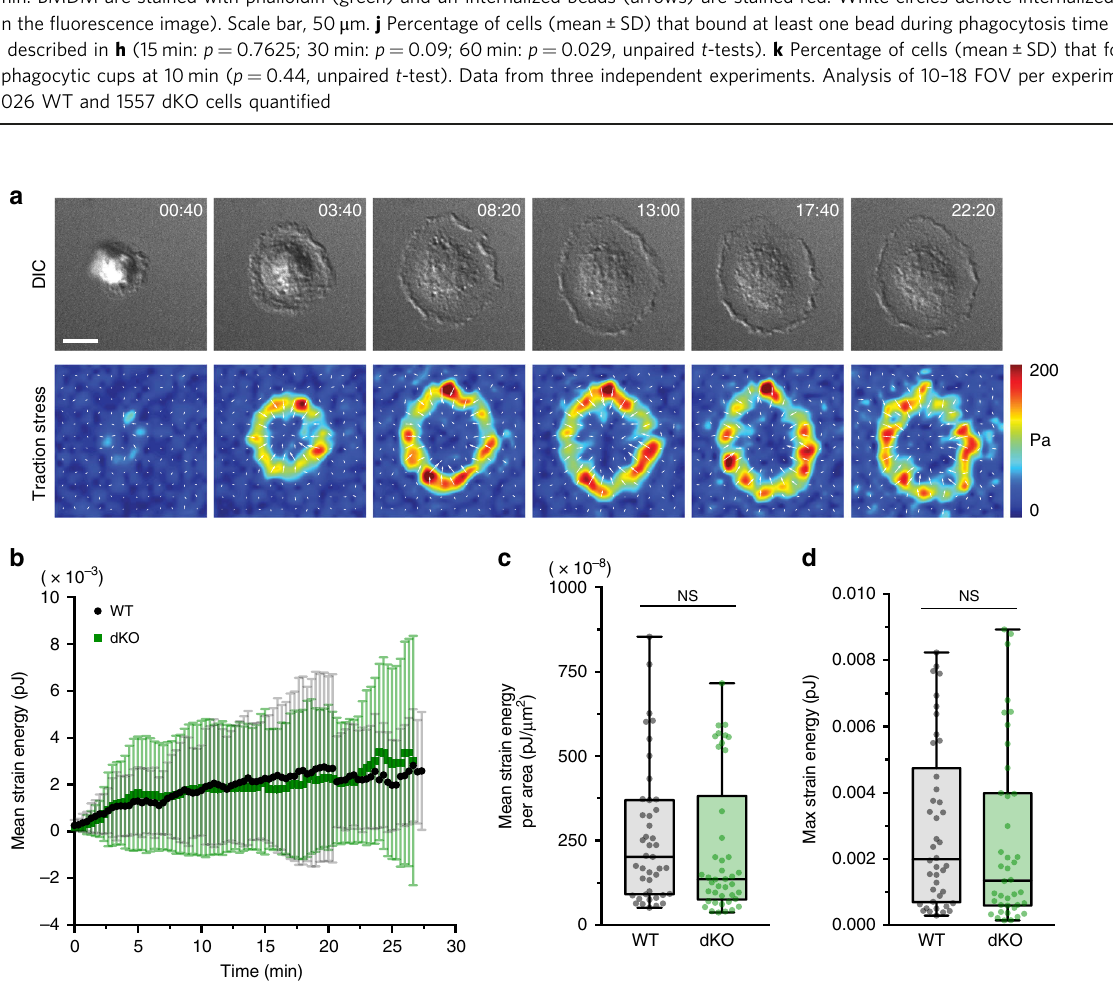
Fig. 2 Myo1e and myo1f do not contribute to phagocytic contractility. a Representative time-lapse montage of BMDM (dKO macrophage) performing frustrated phagocytosis and exhibiting traction forces. Differential interference contrast (DIC) imaging (top) above traction force map (bottom). The magnitude of the brightness in the traction map corresponds to the magnitude of the stress (i.e., a pixel value of 50 = 50 Pa), with the pixel intensity values color-coded as indicated by the color wedge on the right. Scale bar, 10 μ m. See also Supplementary Movie 3. b Graph of mean strain energy (±SD) over time during spreading. WT and dKO macrophages performed frustrated phagocytosis for TFM measurements. Data from two independent experiments ( n = 44 WT and 42 dKO cells). c Graph of mean strain energy per unit of cell area. Box and whisker plot shows median, 25th and 75th percentile, with error bars depicting maximum and minimum data points. ( n = 43 WT and 42 dKO cells). Two outliers have been removed ( p = 0.43, unpaired t -test). d Graph of maximum strain energy measured over 30 min of cell spreading. Box and whisker plot shows median, 25th and 75th percentile, with error bars depicting maximum and minimum data points. ( n = 42 WT and 40 dKO cells). Four outliers have been removed ( p = 0.48, unpaired t